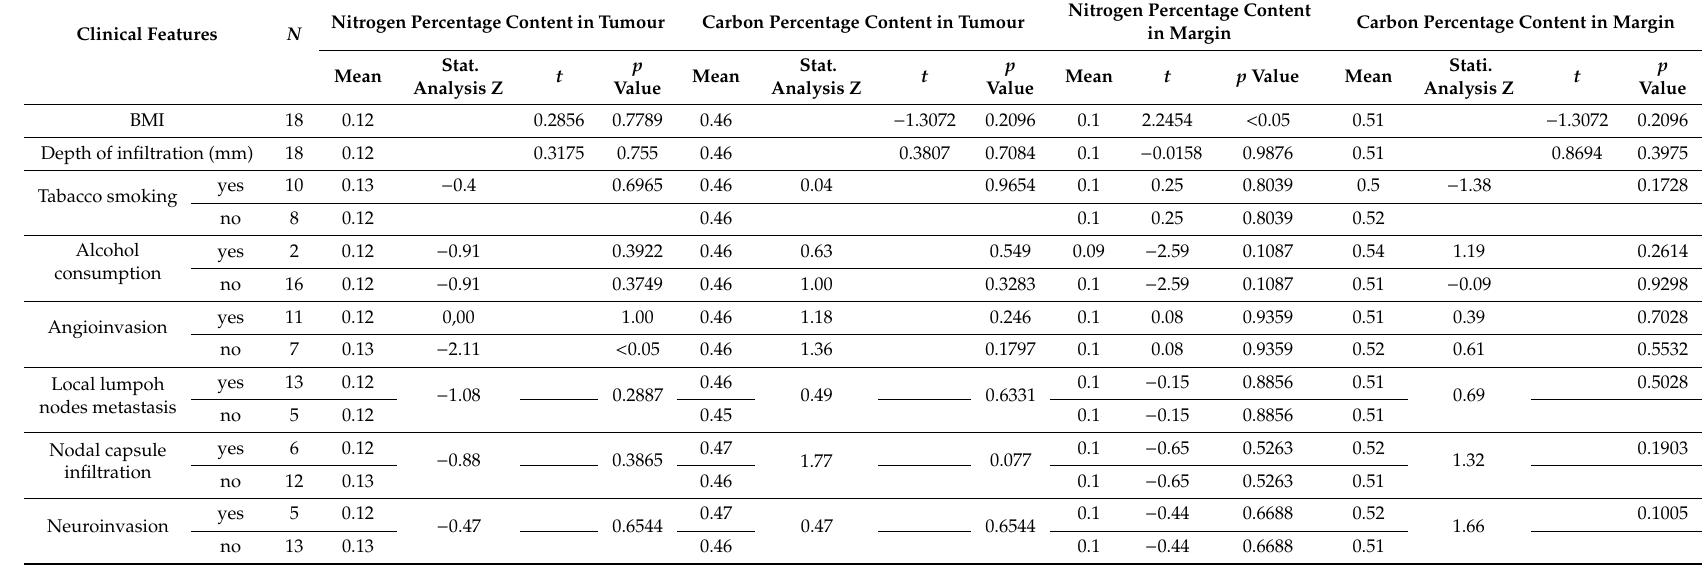
Table 4. Comparison of percentage content of nitrogen and carbon in tumour and margin and clinical